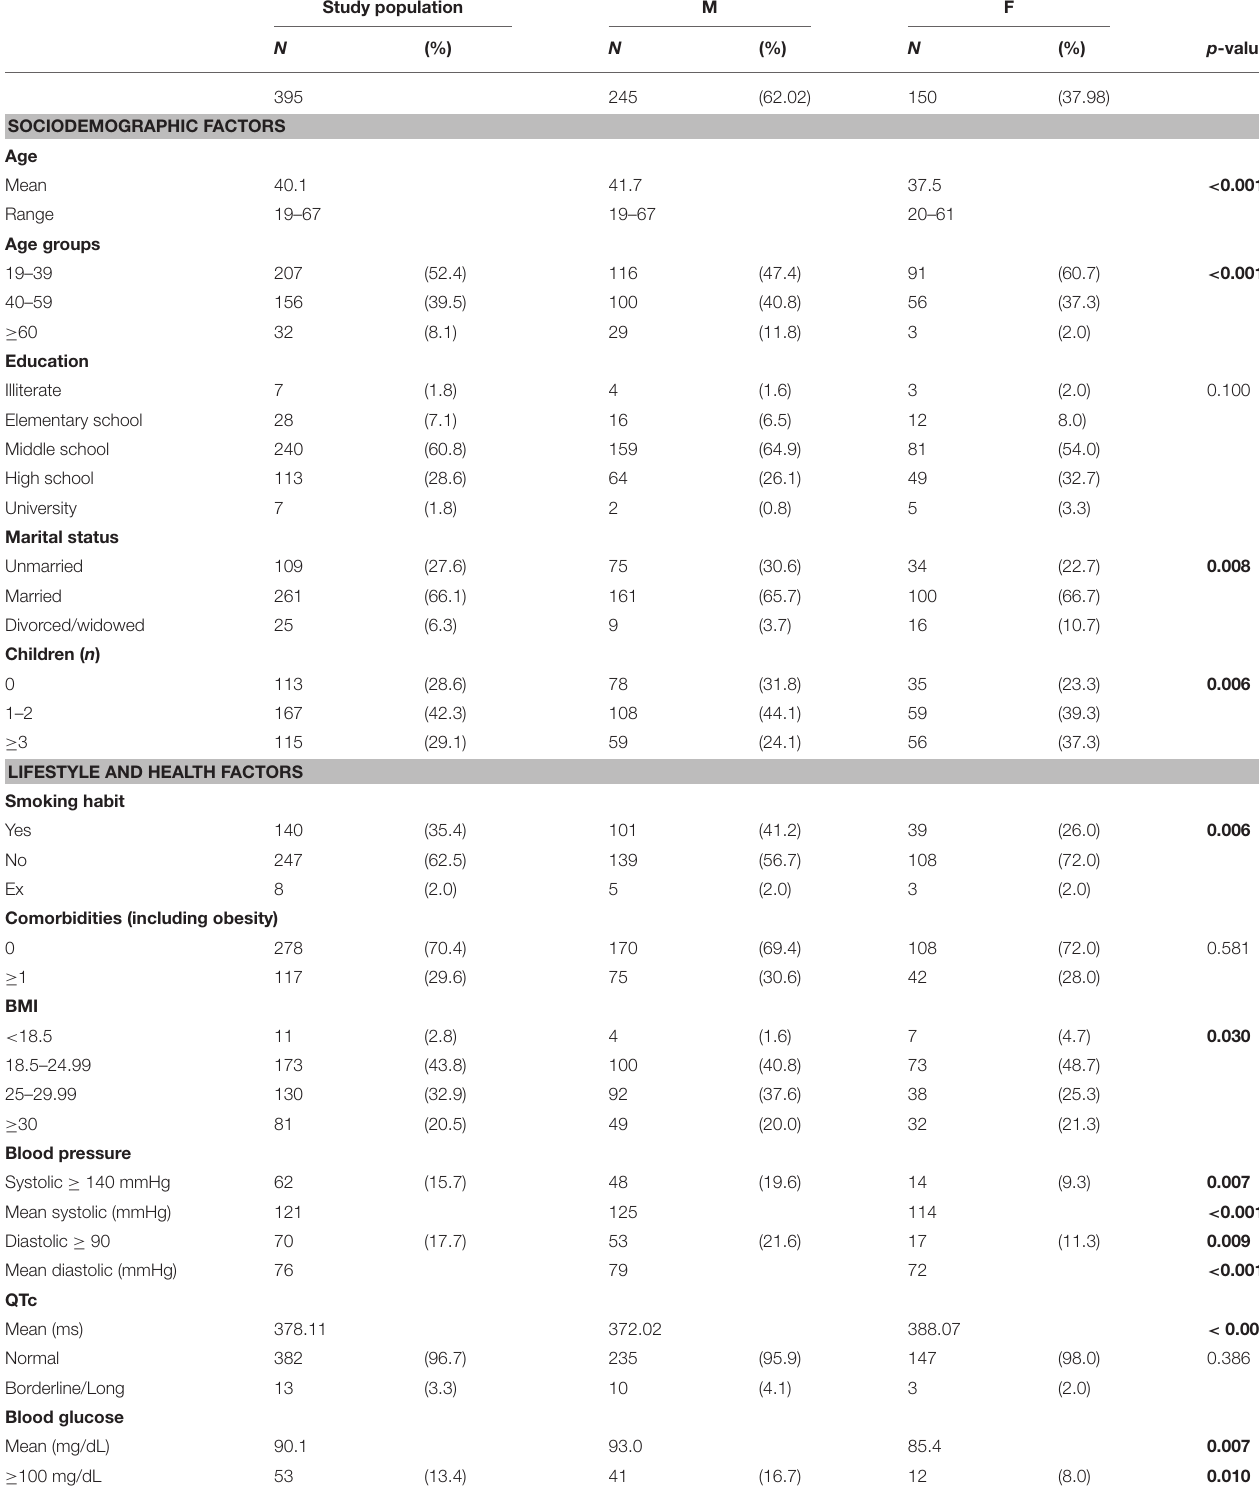
TABLE 1 | Sociodemographic characteristics, lifestyle, and health factors of study